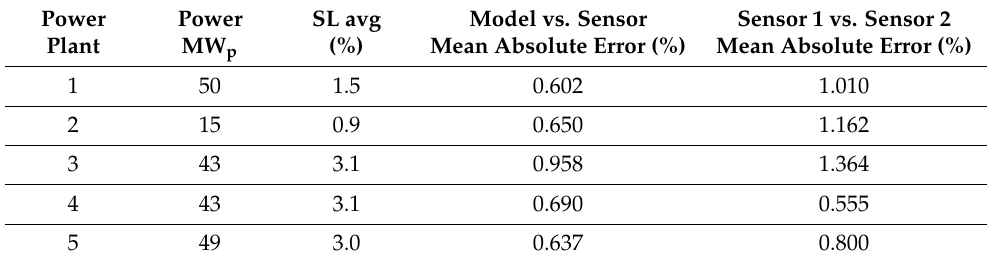
Table 3. Comparisons results on the five PV power plants.